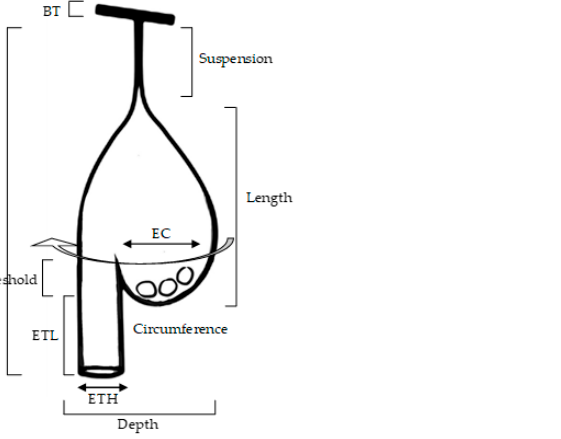
Figure 2. Nest structure of a complete nest of baya weaver ( Ploceus philippinus ). EC, egg chamber; ETH, entrance tube hole; BT, branch thickness; TL, total length; ETL, entrance tube length (Figure adapted from Quader [18]).